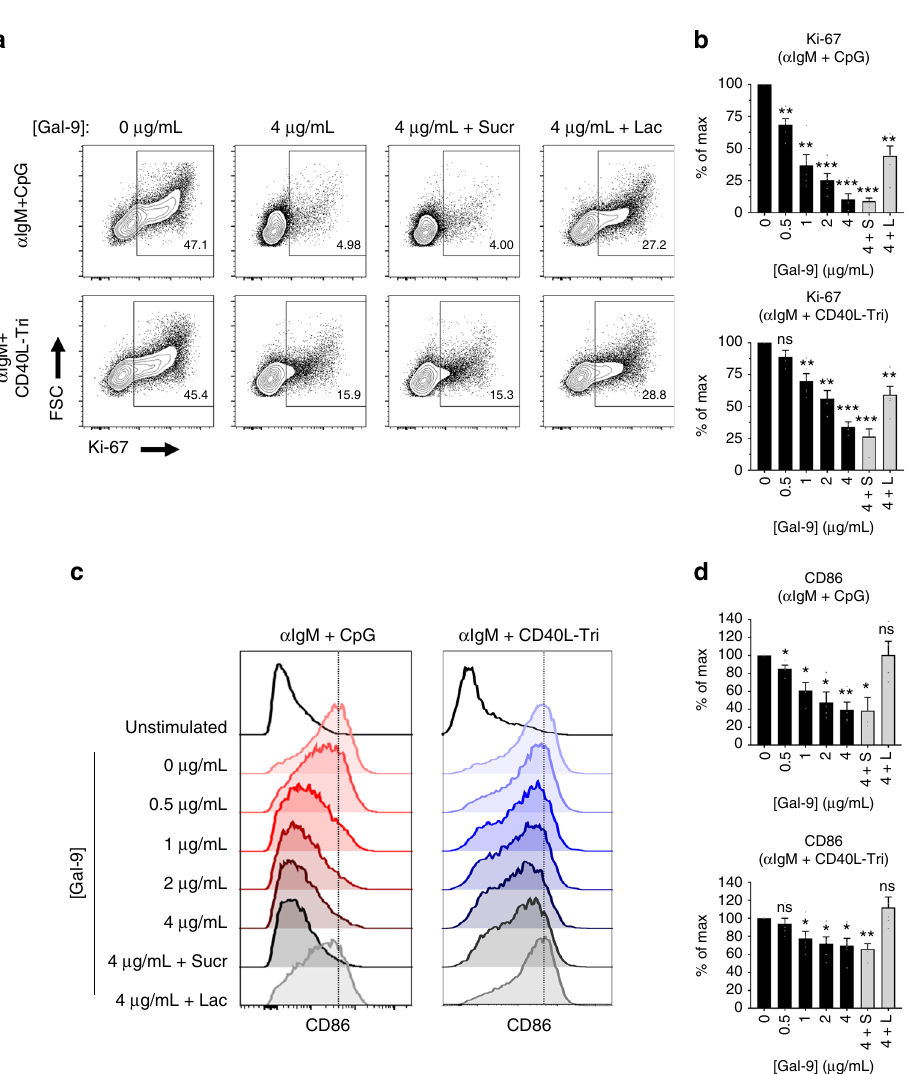
Fig. 6 Gal-9 inhibits B cell activation and proliferation. a Representative contour plots and b quanti fi cation of naive B cell proliferation 40 h post-activation with either T-independent (anti-IgM F(ab ’ ) 2 + unmethylated CpG oligonucleotides + IL-2/4/10) or T-dependent stimulation (anti-IgM F(ab ’ ) 2 + recombinant CD40L-trimer + IL-2/4/10/21), in the presence or absence of the indicated concentration of recombinant Gal-9. “ 4 + L ” indicates 4 μ g Gal-9 plus 10 mM lactose; “ 4 + S ” indicates 4 μ g Gal-9 plus 10 mM sucrose, a non-inhibitory osmolarity control. c Representative histograms and d quanti fi cation of CD86 (B7-2) expression on naive B cells 40 h after activation in the presence or absence of Gal-9 at the indicated concentrations, as in b . For a and c , data are representative of fi ve independent experiments. For b and d , n = 5 distinct tonsil specimens pooled from fi ve independent experiments. For b , and d , statistics were calculated using a one-sample t -test against a hypothetical value of 100. Throughout, bars and error bars depict mean and SEM, respectively. ns = not signi fi cant, * p < 0.05, ** p < 0.01, *** p <